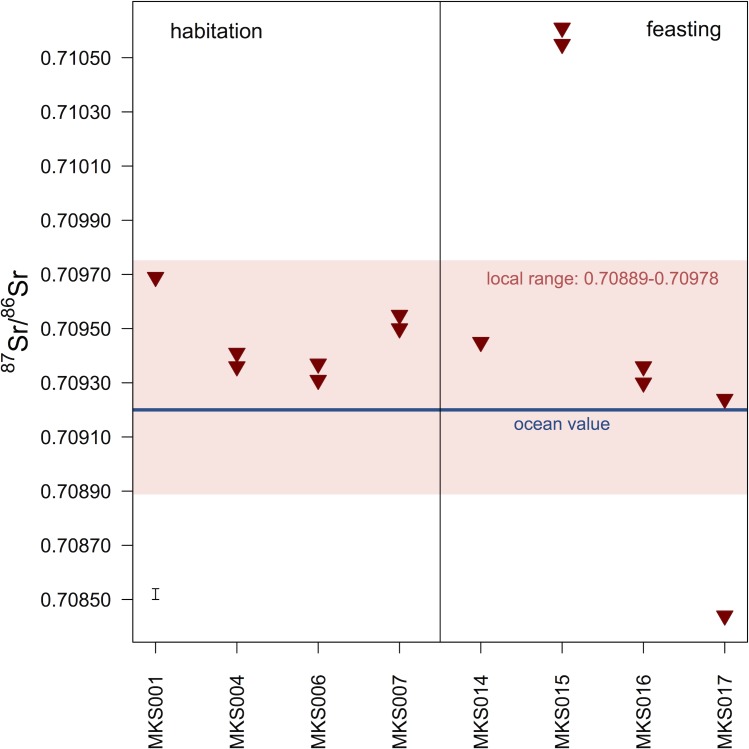
Archaeological tooth enamel 87Sr/86Sr ratios from Makriyalos.All samples were previously measured in Stage 2. Each tooth was sampled twice: 1) in the region that mineralized during the summer and 2) in the region that mineralized during the winter (determined using the δ18Omax and δ18Omin values, respectively). Measurement error is shown in the bottom-left corner of the plot.